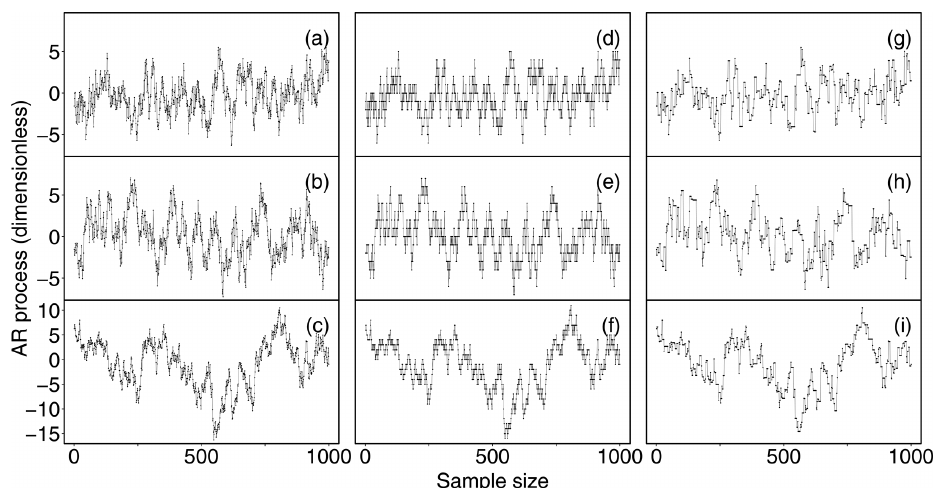
Figure 2. Three realizations of AR processes of length 1000 with φ = 0 . 9 (a) , φ = 0 . 95 (b) and φ = 0 . 99 (c) , affected by low-resolution problems simulated by discretizing the original variable (d–f) and by replacing 60% of original data via the last-observation-carried-forward (LOCF) technique (g–i)